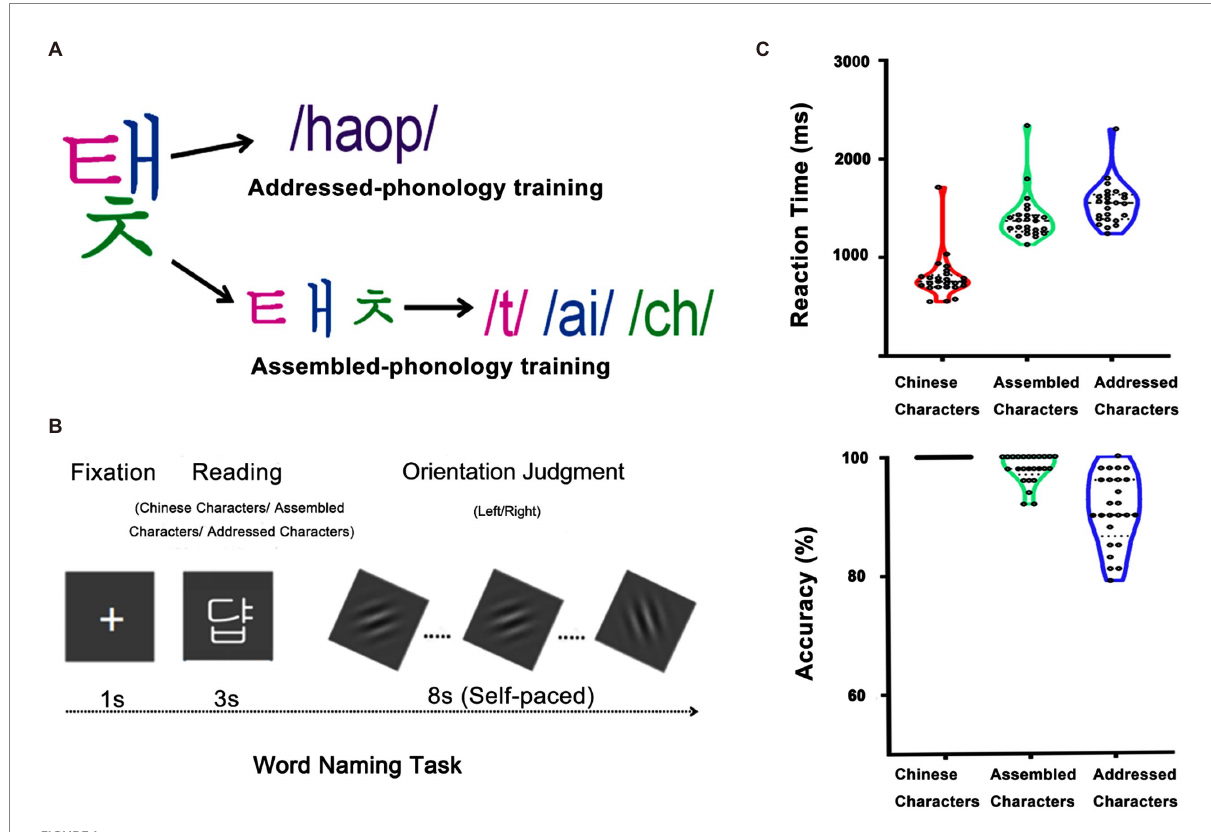
FIGURE 1 Participants were asked to learn the associations between visual forms and sounds of 32 different artificial language characters. Half were learned through addressed phonology and the other half were learned through assembled phonology (A) . After training, they performed one session of the word naming task during scanning and another session outside the scanner, in which they were asked to read each character aloud (B) . The right panels showed reaction times and accuracies of Chinese characters, assembled and addressed characters after the scan (C)